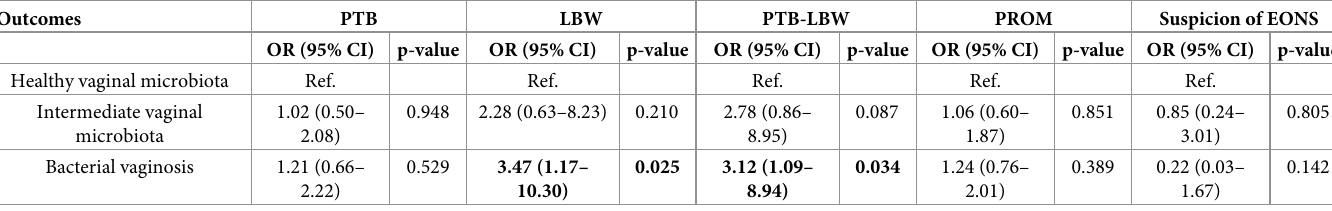
CI, confidence interval; EONS, early-onset neonatal sepsis; LBW, low birth weight; OR, Odds ratio; PROM, premature ruptures of membranes; PTB, preterm birth; PTB-LBW, preterm birth of a low birth weight newborn; Ref., Reference category; Bold, p <